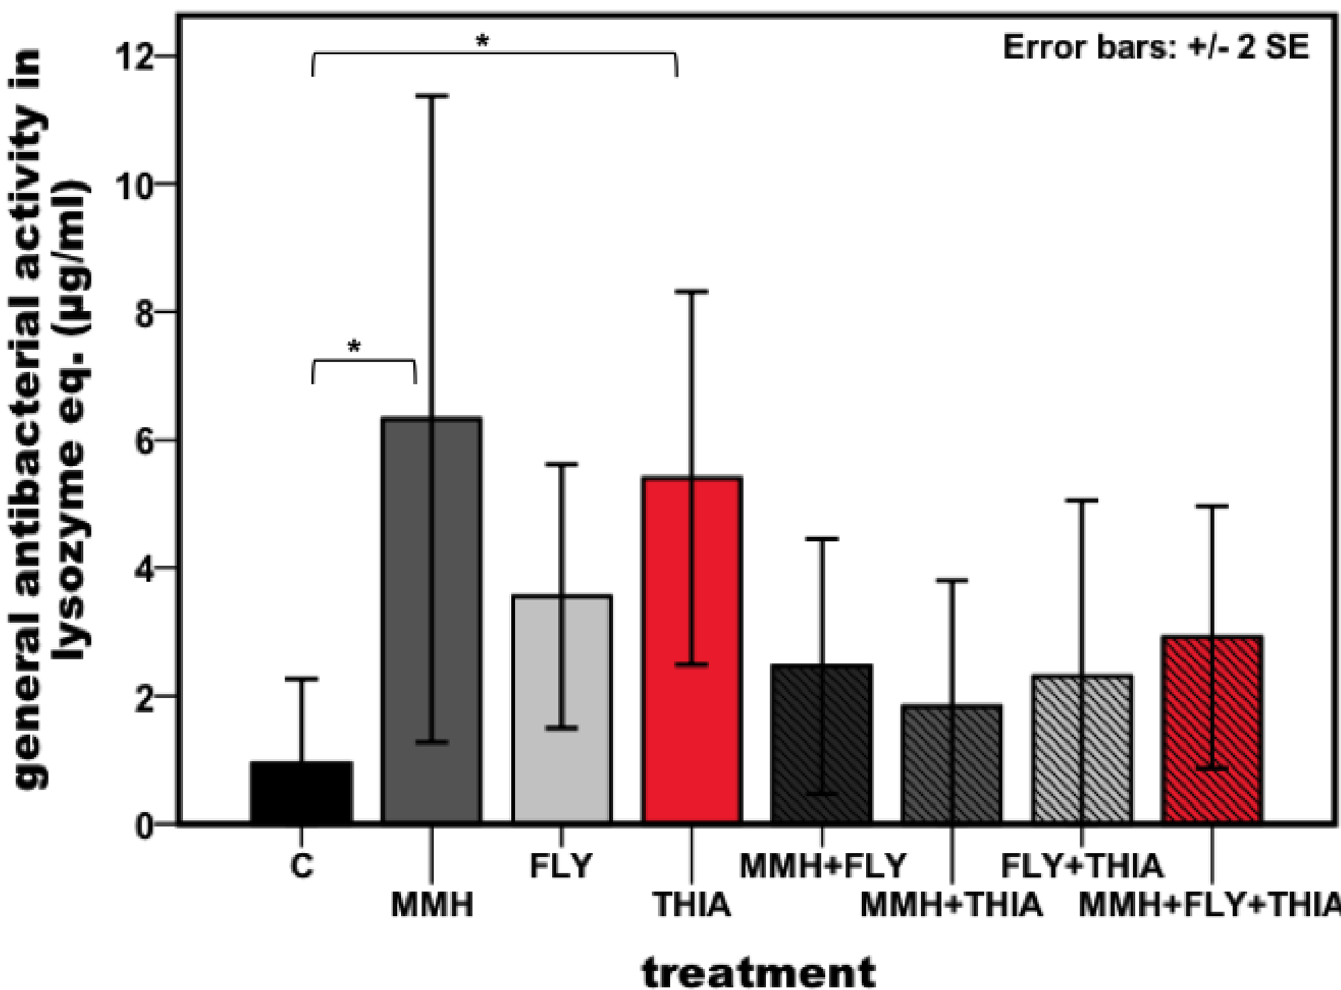
Fig 3. Lysozyme-like activity in the haemolymph of honeybees after being exposed to thiacloprid and E . faecalis . General antibacterial activity measured as the diameter of the lytic zone on agar plates, transformed to lysozyme equivalents ( μ g/ml). Different enzyme activity in the haemolymph as a result of all possible different diet combinations as well as single stress exposure (C = control, MMH = E . faecalis strain MMH594, FLY = E . faecalis strain FLY1, THIA = thiacloprid). Asterisks indicate differences in the lysozyme-like activity, (cid:3) (cid:20) 0.005, (cid:3)(cid:3) (cid:20) 0.001, (cid:3)(cid:3)(cid:3) (cid:20) 0.0001. Results represent mean values ± 2 s.e.m, Kurskal-Wallis test, n = 16 for each treatment group. Bars are indicated in: black = control, dark-grey = MMH, light-grey = FLY, red = THIA, shaded black = MMH+FLY, shaded dark-grey = MMH+THIA, shaded light-grey = FLY+THIA, shaded red = MMH+FLY+THIA.